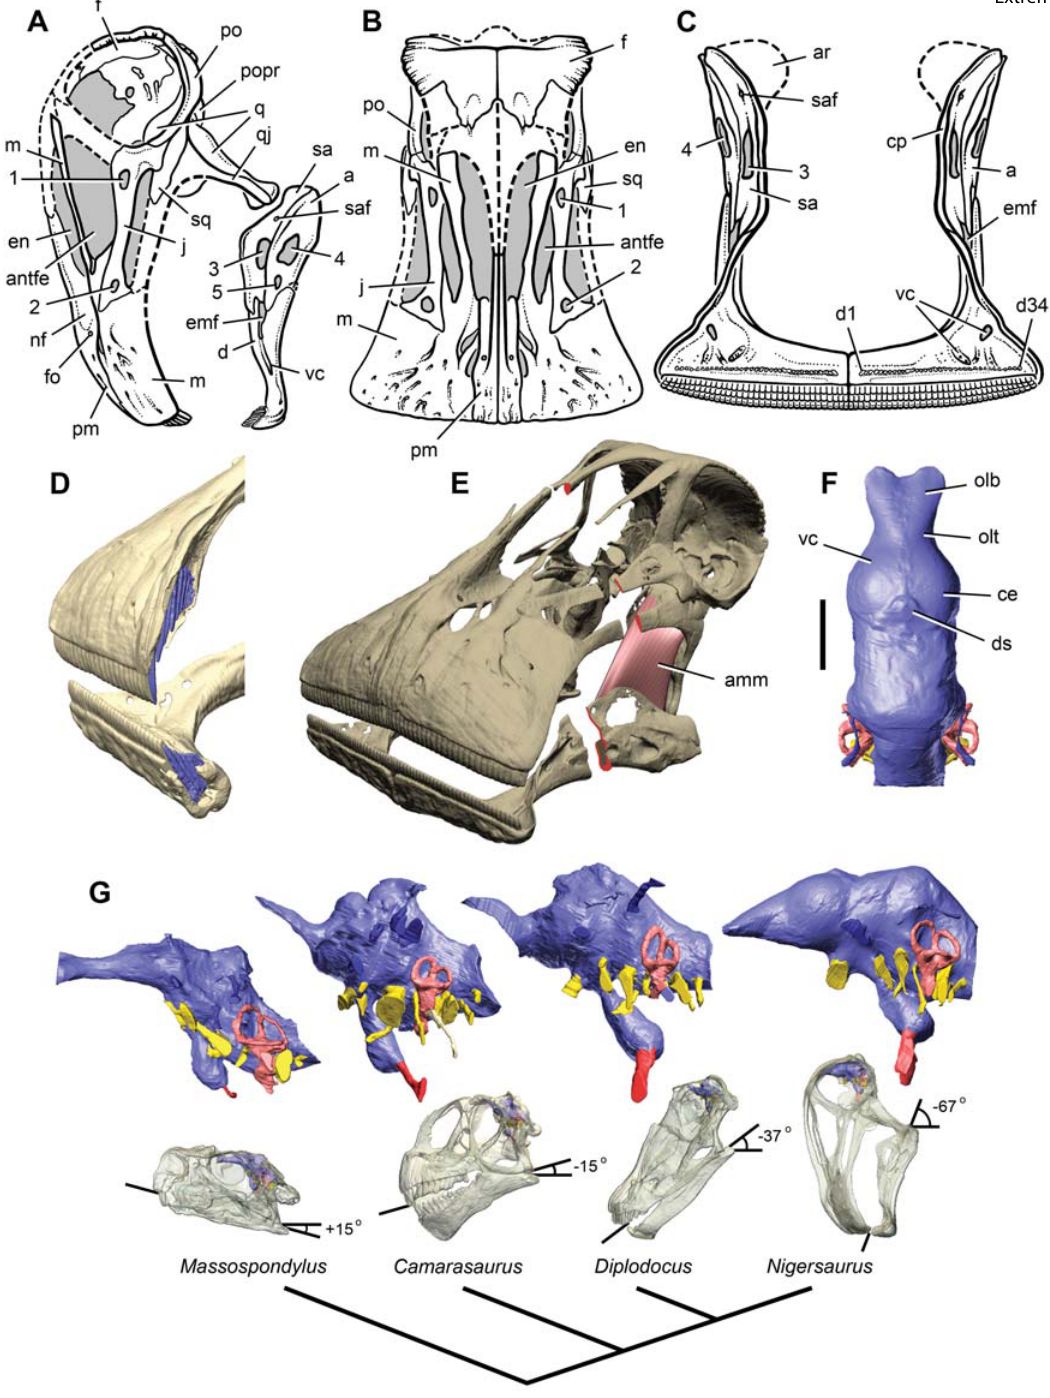
Figure 1. Skull of Nigersaurustaquetiand head posture in sauropodomorphs. (A)-Lateral view of skull (MNN GAD512). (B)-Anterodorsal view of cranium. (C)-Anterior view of lower jaws. (D)-Premaxillary and dentary tooth series (blue) reconstructed from m CT scans. (E)-Skull reconstruction in anterolateral and dorsal view cut at mid length between muzzle and occipital units (cross-section in red) with the adductor mandibulae muscle shown between the quadrate and surangular. (F)-Endocast in dorsal view showing the cerebrum and olfactory bulbs. (G)-Endocast (above) and transparent skulls with endocasts in place (below) based on m CT scans of the basal sauropodomorph Massospondylus carinatus (BP 1/4779), the basal neosauropod Camarasaurus lentus (CM 11338), the diplodocid Diplodocus longus (CM 11161), and the prototype skull of the rebbachisaurid Nigersaurus taqueti . Endocasts and skulls are oriented with the lateral semicircular canal held horizontal; the angle measurement indicates degrees from the horizontal for a line from the jaw joint to the tip of the upper teeth. Endocasts show brain space and dural sinuses (blue), nerve openings (yellow), inner ear (pink), and internal carotid artery (red). Phylogenetic diagram at bottom shows the relationships of these four sauropodomorphs, with increasing ventral deflection of the snout toward the condition seen in Nigersaurus . Scale bar equals 2 cm in F. Abbreviations : 1–5 , fenestrae 1–5; a , angular; amm , adductor mandibulae muscle; antfe , antorbital fenestra; ar , articular; ce , cerebrum; cp , coronoid process; d , dentary; d1 , 34 , dentary tooth 1, 34; ds , dural sinus; emf , external mandibular fenestra; en , external nares; f , frontal; fo , foramen; j , jugal; m , maxilla; nf , narial fossa; olb , olfactory bulb; olt , olfactory tract; pm , premaxilla; po , postorbital; popr , paroccipital process; q , quadrate; qj , quadratojugal; sa , surangular, saf , surangular foramen; sq , squamosal; vc , vascular canal. doi:10.1371/journal.pone.0001230.g001 PLoS ONE |